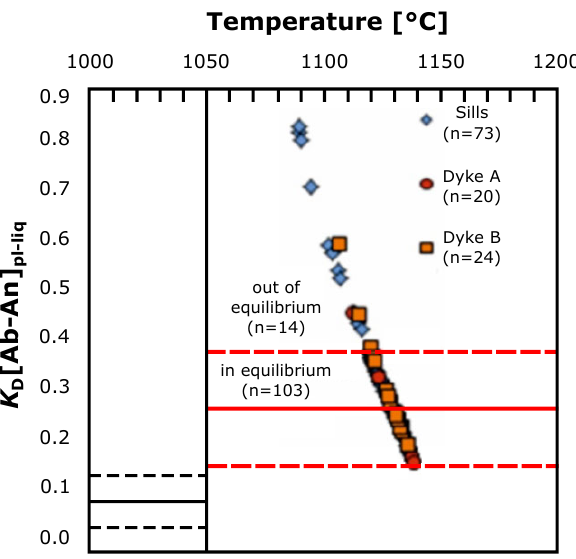
Figure 6: Results from equilibrium test and thermobarome- try for plagioclase mineral in three representative intrusions (dykes and sills) in Leirfjall. Table 1: Permeability of the magmatic intrusions that changes linearly as a function of temperature [cf. Hanson and Barton 1989; Foumier 1991; Hayba and Ingebritsen 1997; Gerdes et al.